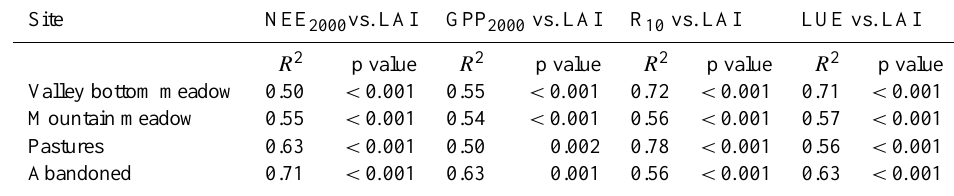
Table 2. Regression statistics of the relationships between the net ecosystem CO 2 exchange at a PFD of 2000µmolm − 2 s − 1 (NEE 2000 ) , the and the light use efficiency (LUE) in response to leaf area index (LAI). The following functions were used: NEE 2000 vs. LAI: cubic and linear, GPP 2000 vs. LAI: cubic and linear, R10 vs. LAI exponential- and linear, LUE vs. LAI: cubic and linear.